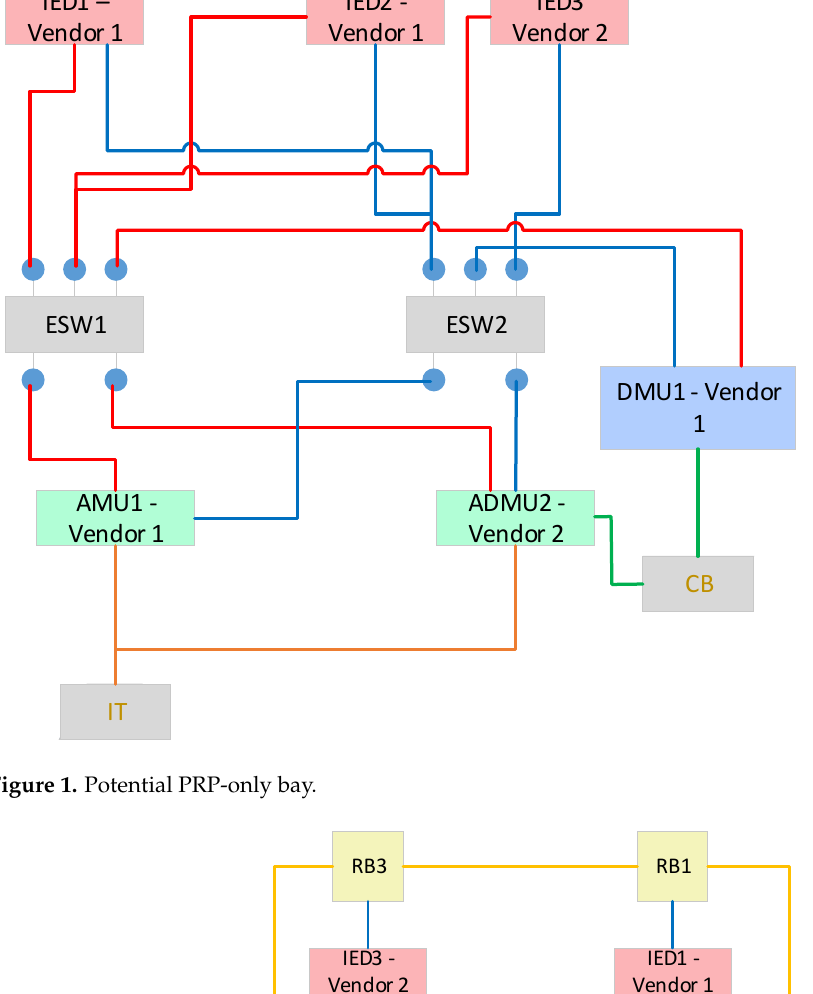
Figure 1. Potential PRP-only bay.